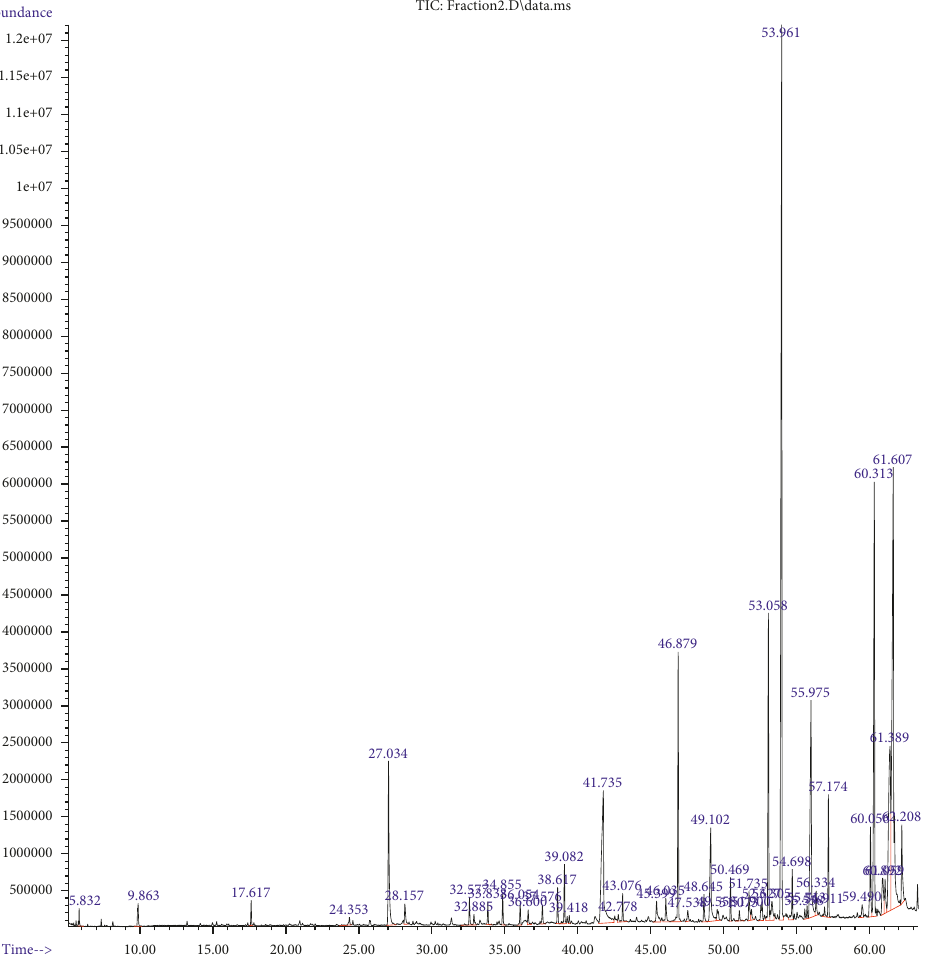
Figure 2: GC-MS chromatogram of petroleum ether extract of N